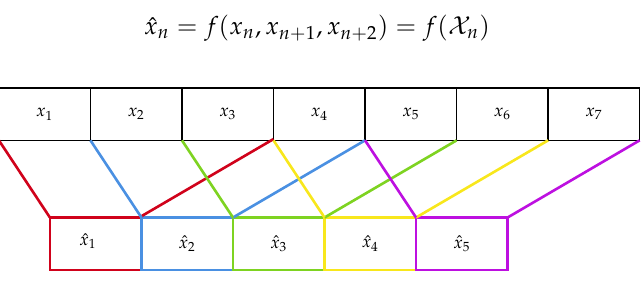
Figure 2. Pooling illustration for the